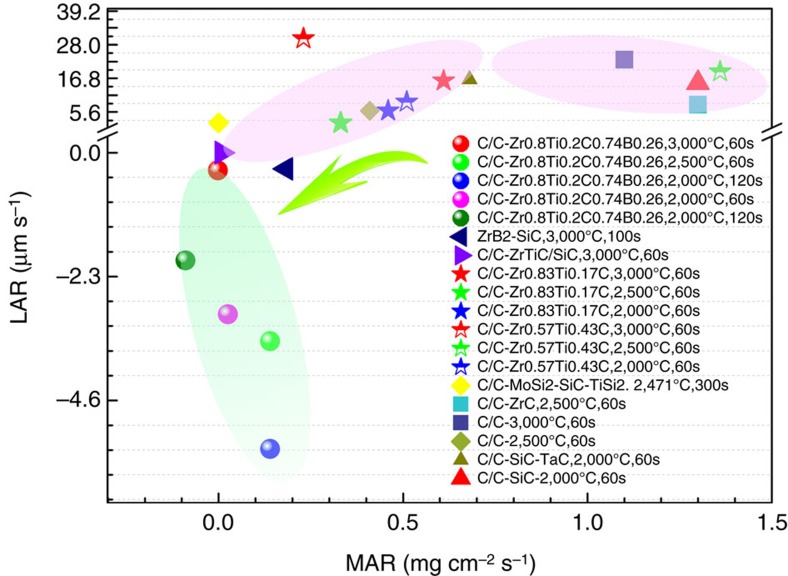
Ablation performance of Zr0.8Ti0.2C0.74B0.26 composites.Comparison of the ablation rates (MAR and LAR) for a range of candidate UHTC composites including: ZrC (RMI)29, SiC (RMI), SiC-TaC (CVI)42, Zr0.83Ti0.17C (RMI)29, Zr0.57Ti0.43C (RMI)29, ZrTiC-SiC (RMI), MoSi2-SiC-TiSi2 (RMI)43, ZrB2-SiC (SPS) and C/C composites (CVI), as well as the Zr0.8Ti0.2C0.74B0.26 studied here (fabrication methods shown in brackets). Above ablation tests were conducted by authors in oxyacetylene machine.